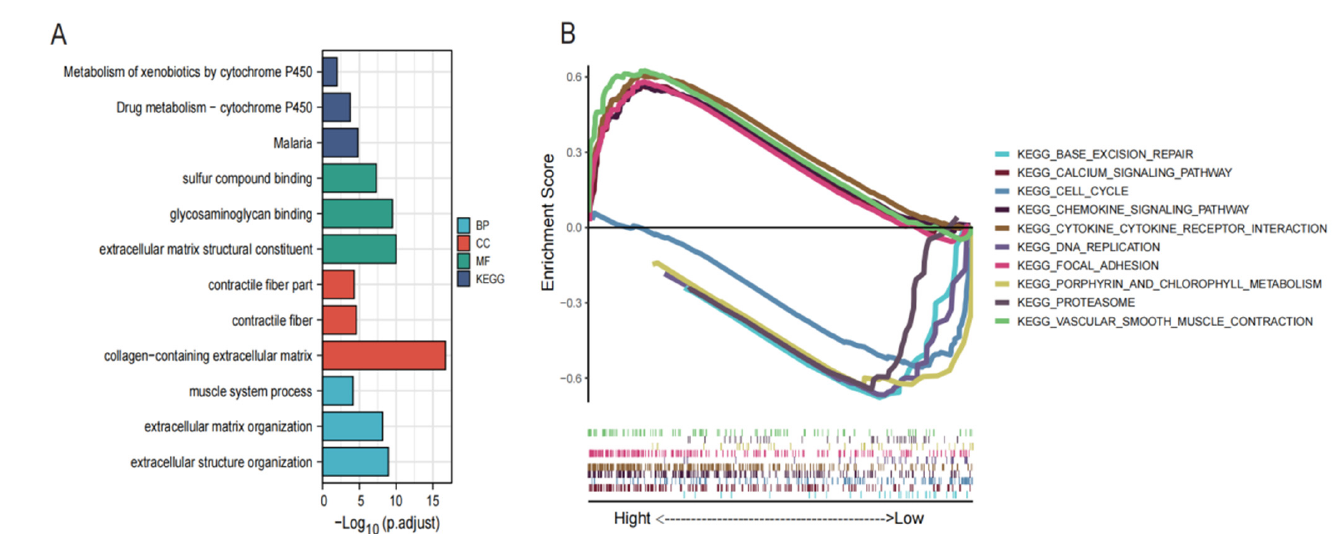
Figure 6. Functional annotations of DEGs. ( A ) GO and KEGG functional enrichment of DEGs. ( B ) GSEA for significantly enriched pathways.